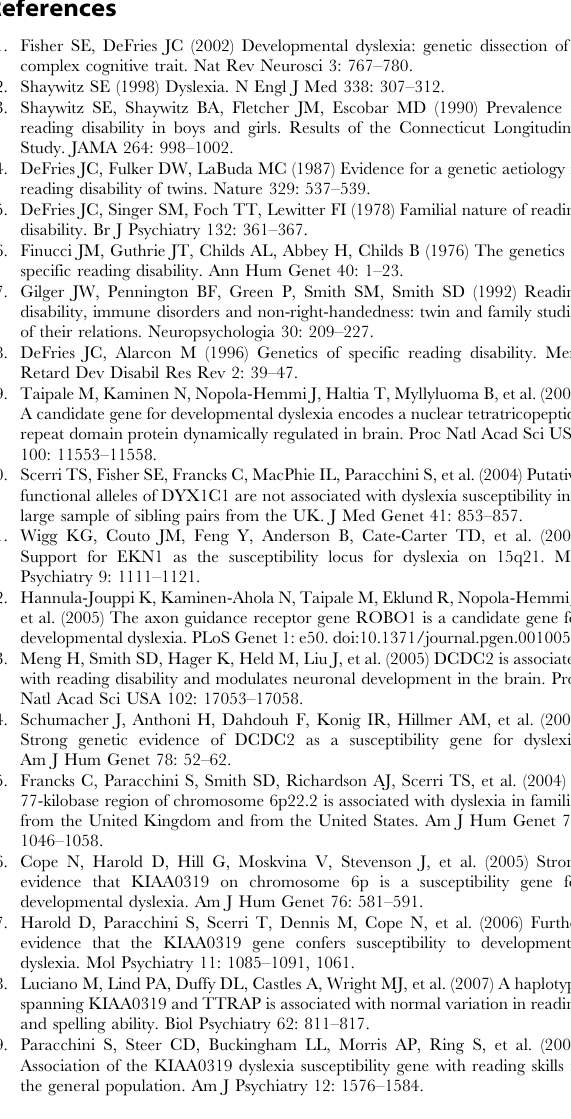
Figure S2 Figure S2. LD structure of four HapMap populations at the KIAA0319 locus. D’ values are indicated, as represented through Haploview version 3.32. The black diamonds indicate LD values between rs2143340 (the risk haplotype-tagging SNP) and rs9461045 (SNP 2). Strong LD (red squares) between rs2143340 and SNP 2 is detected only in the population of European origin. Adapted from Paracchini et al. [19]. Table S1 Table S1. Marker-trait association P-values in sample 1 (89 families). Table S2 Table S2. Genotype statistics for KIAA0319 promoter region SNPs. Table S3 Table S3. Marker-trait association P-values in the entire U.K. set (264 families) - adapted from Harold et al. [17].